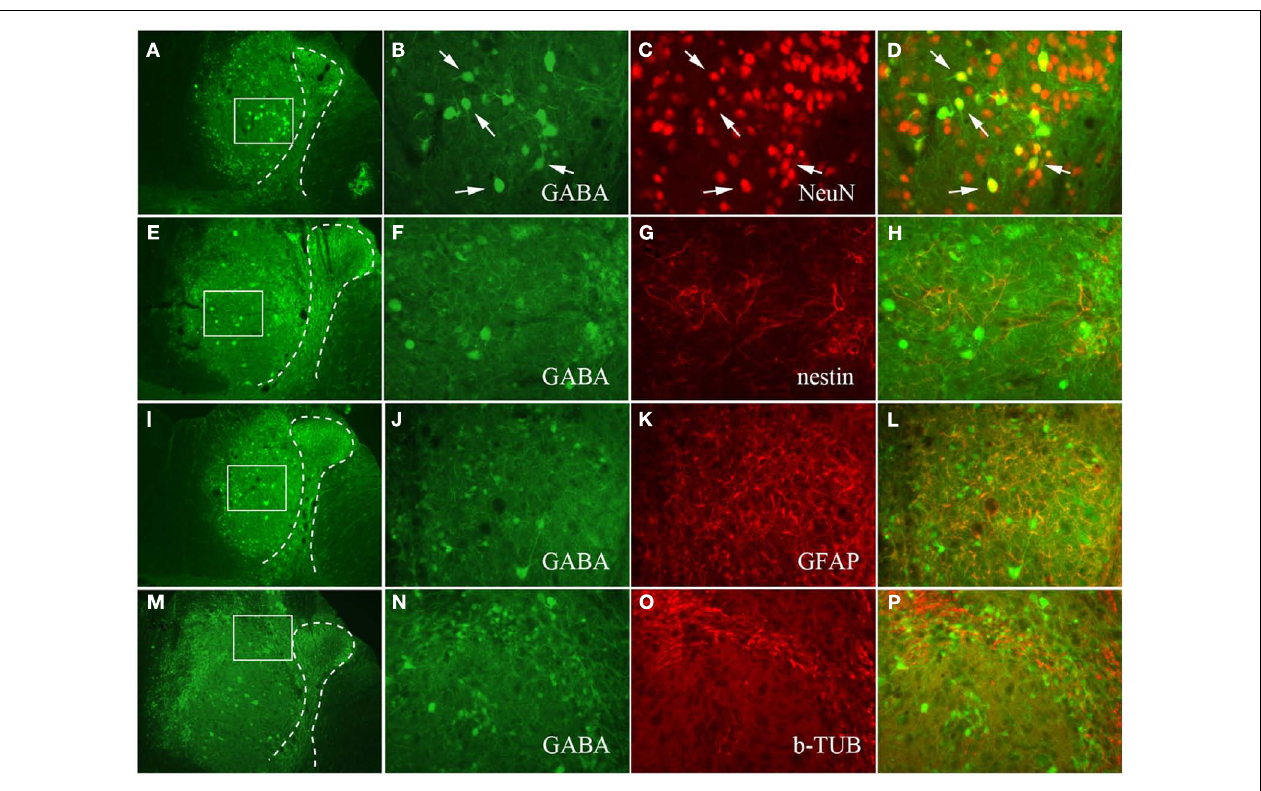
FIGURE 8 | Photomicrographs of QUIS spinal cord transplanted with GABA-IR NPCs. The NPCs were double labeled with NeuN (A–D) , nestin (E–H) , GFAP (I–L) , and β -III-tubulin (M–P) . Medium (A,E,I,M) and high magnification (B,F,J,N) of QUIS spinal cord stained for GABA-IR NPCs.The